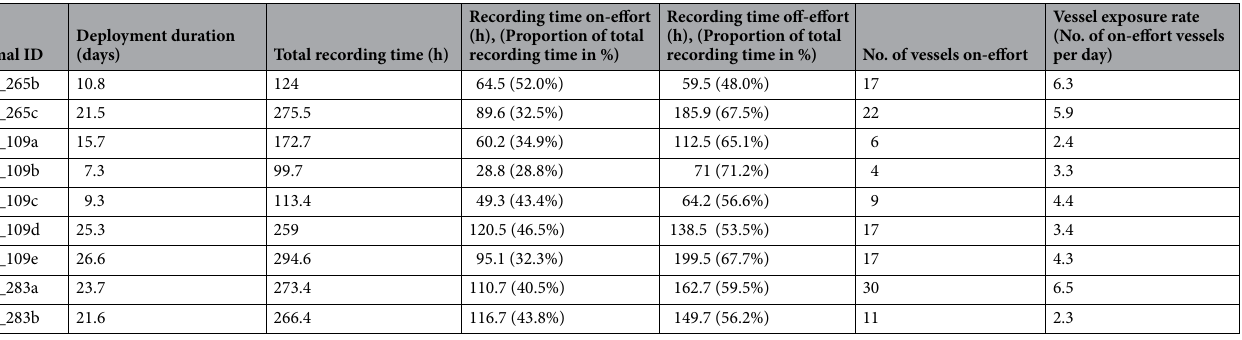
Table 2. Overview on deployment duration, recording times, number of detected vessels and exposure rate to vessels per day for each tagged individual. The total recording time is the effective time when underwater sound levels could be measured, i.e., excluding haul-out, surfacing and outage periods. The recording time on-effort represents the times when the ambient noise in the 2 kHz decidecade was > 6 dB below the detection threshold of 97 dB re 1µPa. The recording time off-effort represents the times when ambient noise was above 91 dB re 1µPa, i.e., noise conditions are not sufficient to reliably detect a vessel. Only vessels detected during on-effort periods are used to calculate exposure rates.